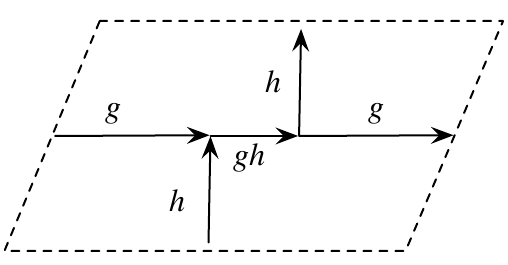
Figure 9 . The lines representing a commuting holonomy ( g; h ) on a